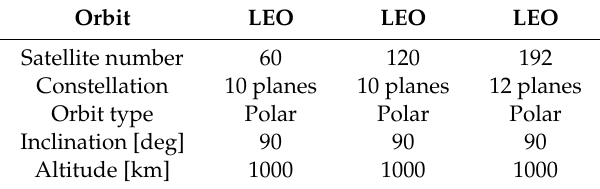
Table 1. Detailed orbital characteristics of the designed low Earth orbit (LEO)